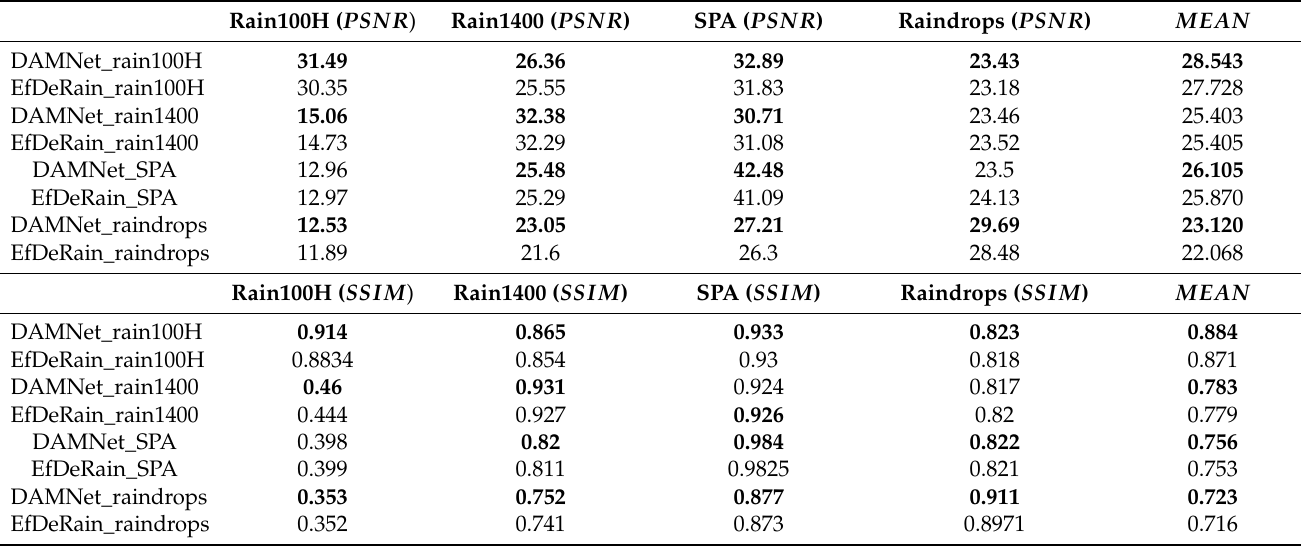
Table 5. The comparison on crossing-rain datasets. The models’ suffixes are datasets for training themselves. DAMNet is the multi-deraining model proposed, and EfDeRain [23] is the model with only one deraining layer. The numbers highlighted in bold denote that DAMNet outperforms EfDeRain on the same crossing datasets under the same